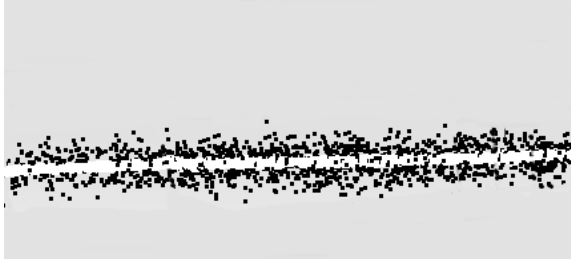
Figure 7. Original road – slope profile (white) and noised profile (black)